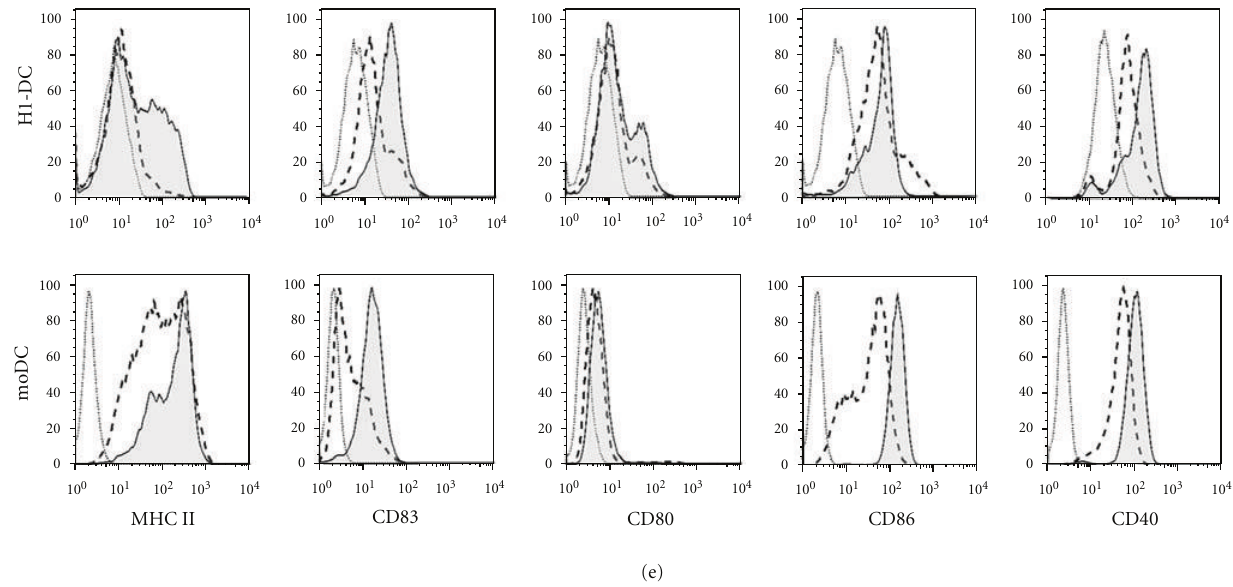
Figure 2: Time course of DC di ff erentiation from H1 hESC. Cells were harvested from cultures at various time points and analysed by flow cytometry for the onset of hematopoiesis and the appearance of DC. (a) Cells harvested at day 20 of culture showing expressing of CD45 but lack of myeloid commitment, as evidenced by staining for CD13, CD14, and CD11c. Open histograms show levels of background staining using isotype-matched control antibodies. (b) Appearance of CD45 int cells at day 27 of culture, accompanied by the upregulation of myeloid-specific markers. (c) Photomicrograph, taken at day 28 of culture, showing the morphology of DC, including veils of cytoplasm and long dendrites (inset) ( × 40 magnification). (d) Cells harvested at day 33 of culture, showing the appearance of a CD45 hi population containing predominantly DC progenitors expressing CD14, CD11c, CD86 and MHC class I. (e) Phenotype of immature and mature H1- DCs compared with human moDC. DCs were cultured either in medium alone or medium supplemented with the maturation cocktail and stained for MHC class II, the maturation marker CD83 and classical costimulatory molecules. Dead cells were excluded from the analysis using 7-AAD. Dashed histograms show the phenotype of immature DCs while the filled histograms represent mature DCs. Open histograms depict background staining using isotype-matched